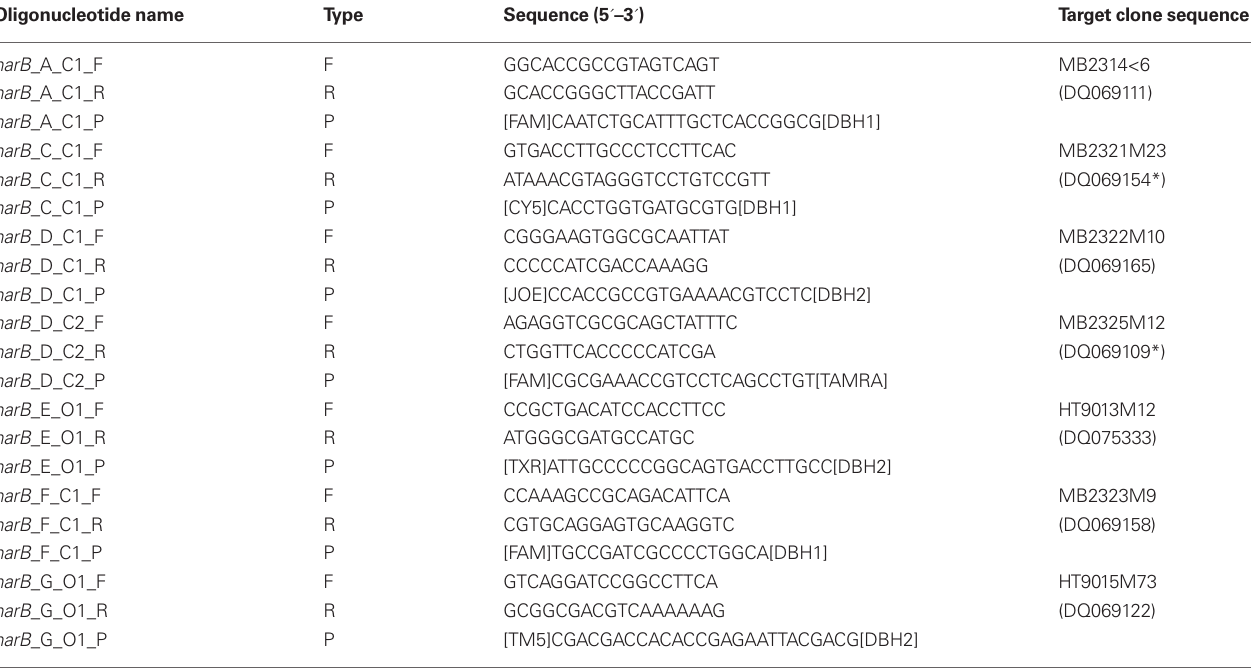
Table 1 | Primers and probe components for each of the developed narB qPCR